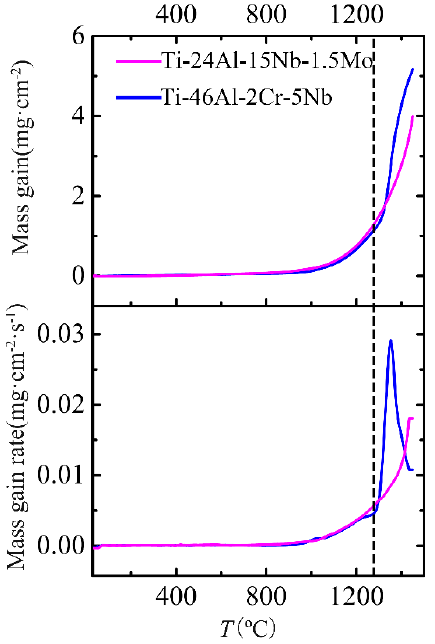
Figure 2. Comparisons of the mass-gain and mass-gain rate curves between the Ti-46Al-2Cr-5Nb and Ti-24Al-15Nb-1.5Mo alloys obtained during non-isothermal oxidation. Ti-24Al-15Nb-1.5Mo alloys obtained during non-isothermal